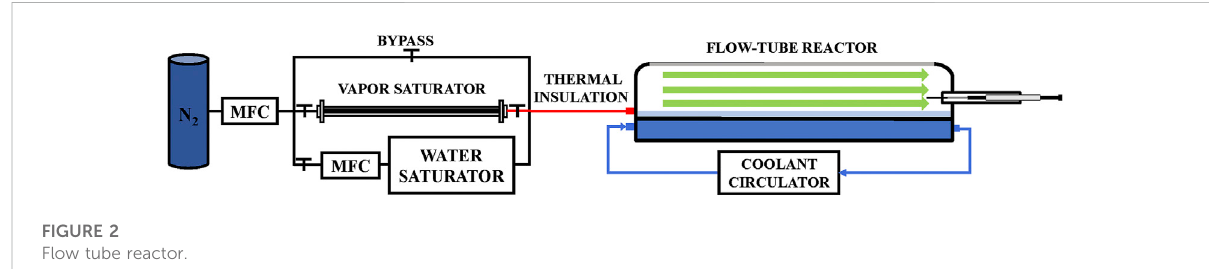
FIGURE 2 Flow tube